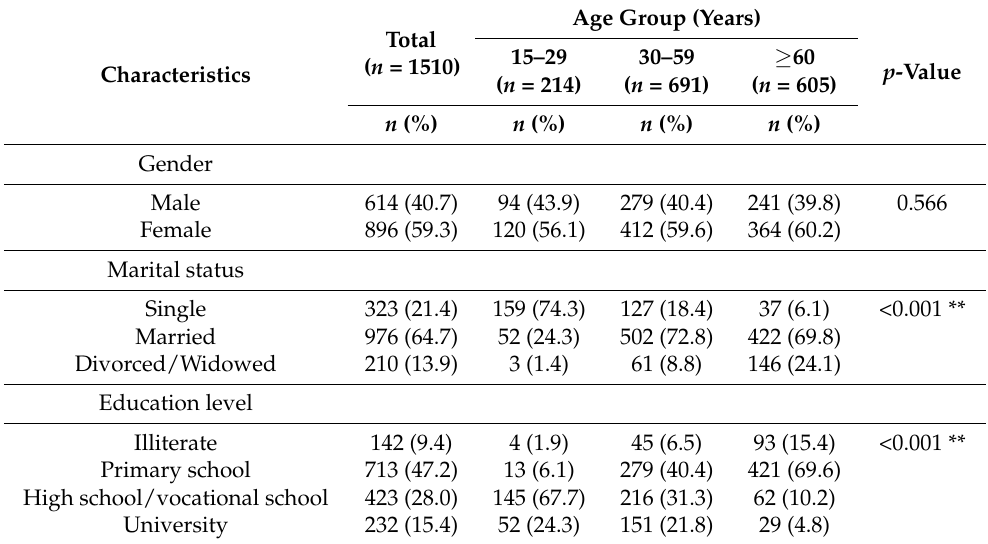
Table 2. Characteristics of the study participants by age-groups.